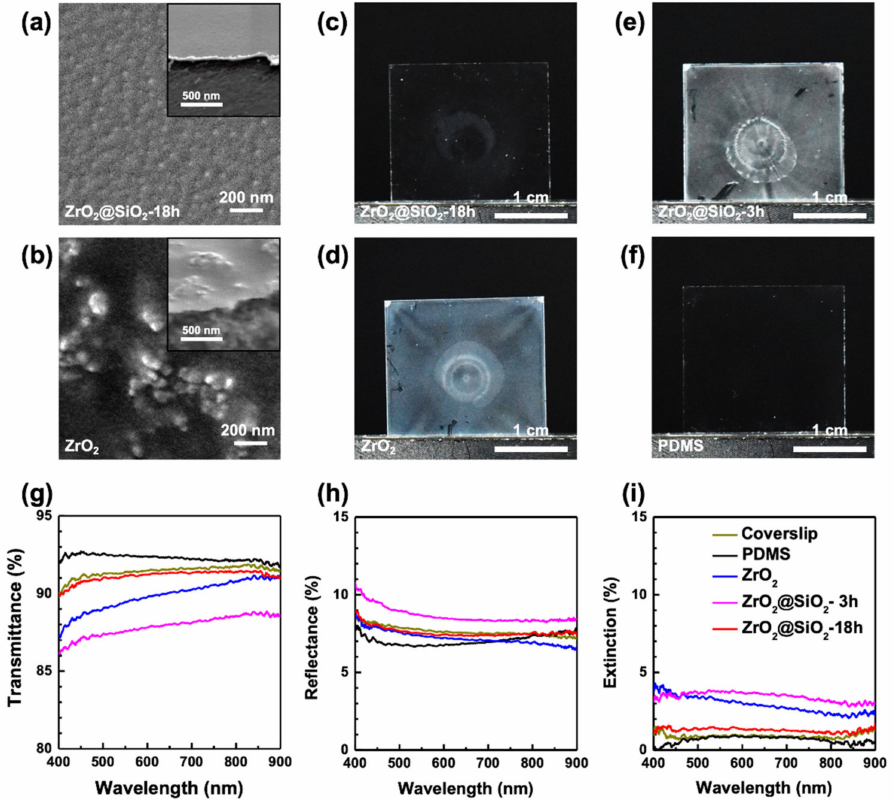
Figure 5. SEM images of ( a ) ZrO 2 @SiO 2 -18h-PDMS and ( b ) ZrO 2 -PDMS films. The inset shows 70 degree SEM images of the film edges of ( a ) ZrO 2 @SiO 2 -18h-PDMS and ( b ) ZrO 2 -PDMS films. Digital pho- tos of ( c ) ZrO 2 @SiO 2 -18h-PDMS, ( d ) ZrO 2 -PDMS, ( e ) ZrO 2 @SiO 2 -3h-PDMS, and ( f ) PDMS films. All films were prepared with 100 nm thickness on Si substrates or coverslips with NP contents of 50 wt%. ( g ) Transmittance (T), ( h ) reflectance (R), and ( i ) extinction (E) spectra of corresponding